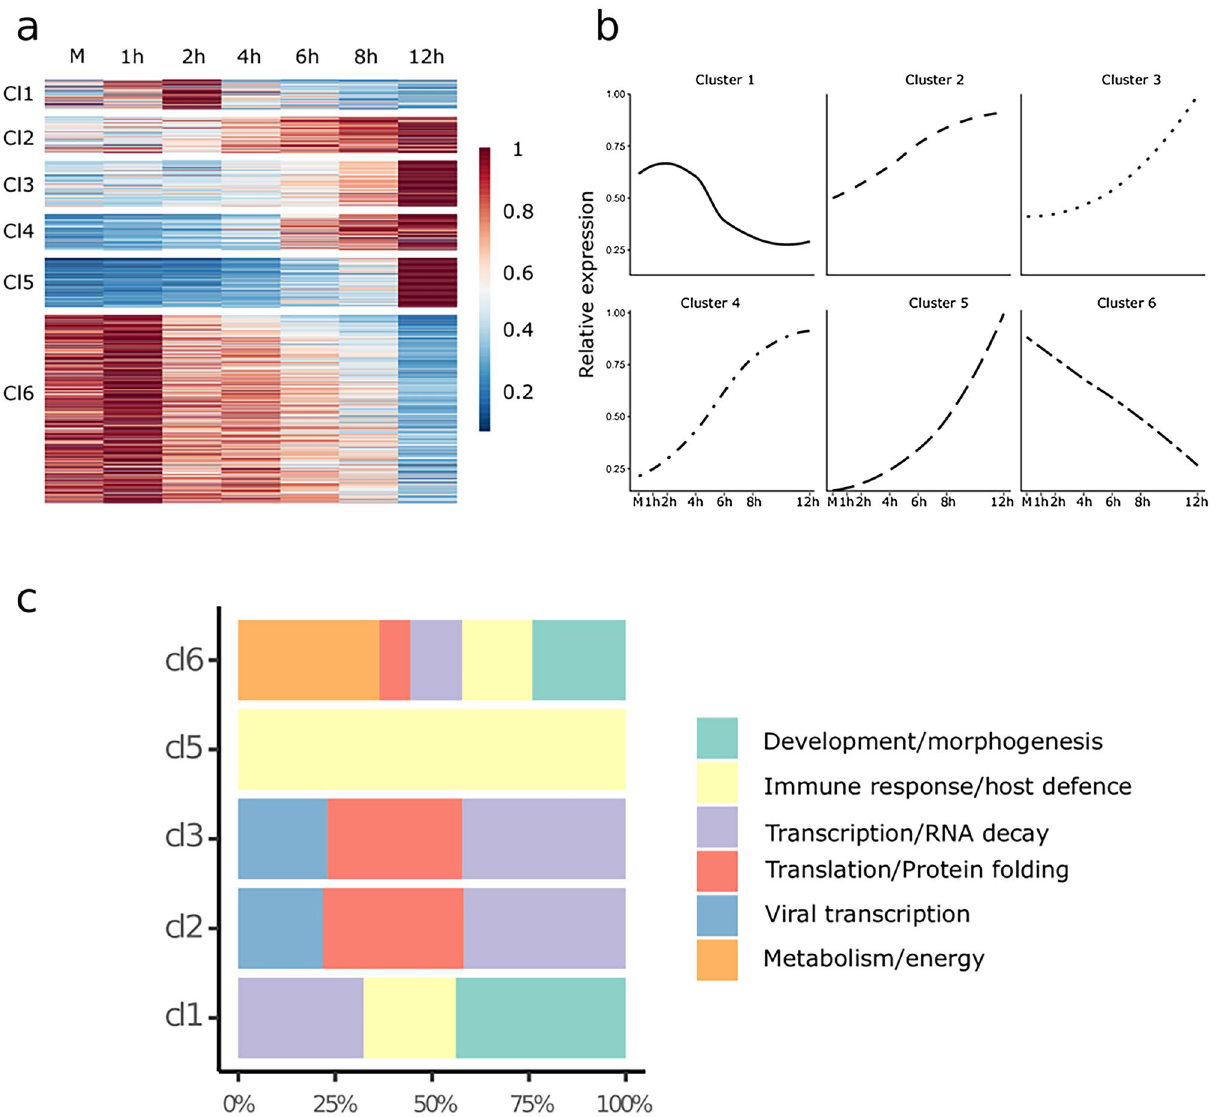
Figure 4. Differential expression analysis of host genes. ( a ) Relative gene expression represented on a heat map. Six distinct kinetic clusters (Cl) were identified among host genes. The scale represents the mean relative gene expression. ( b ) The average change in normalized relative expression of genes present in the six kinetic clusters during infection. ( c ) The distribution of genes associated with the six functional categories according to gene ontology (GO) between the kinetic clusters. The figure was created using R v. 3.6.3 (https:// www.r- proje ct. org/); ggplot2 v. 3.3.3 23 (https:// ggplo t2. tidyv erse. org/ refer ence/ ggplot. html); ComplexHeatmap v. 2.2.2 (https://